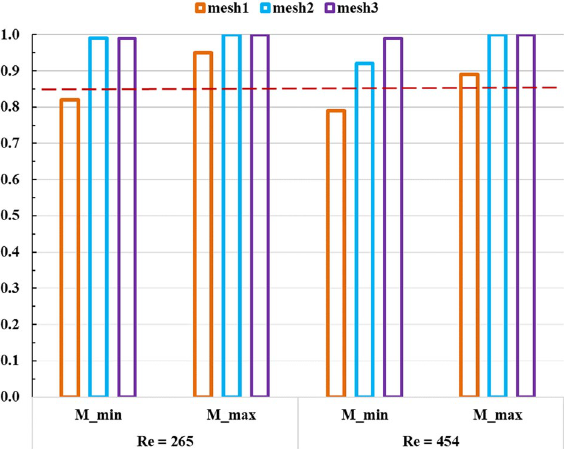
− M ( x i , t ) on y-axis for computational grids of 0.1, 0.5 and 1